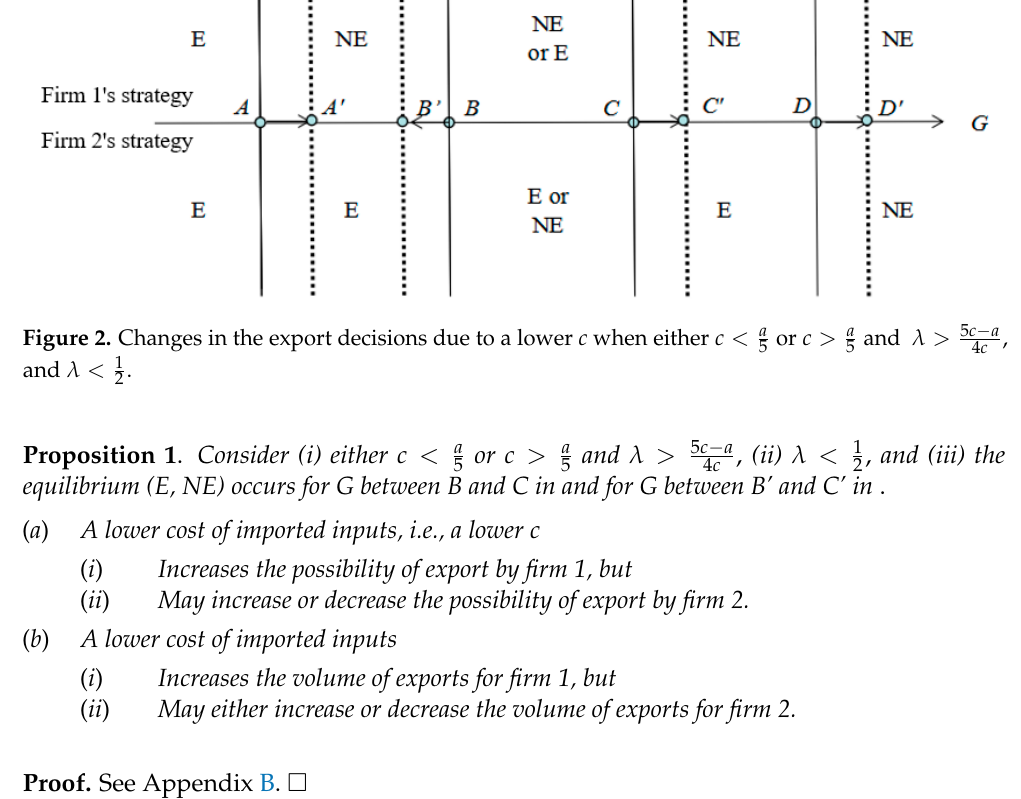
or c > a and λ > 5 c − a , or (cid:1855) > (cid:3028) and (cid:2019) > (cid:2873)(cid:3030)(cid:2879)(cid:3028) , 5 5 4 c (cid:2873) (cid:2873) (cid:2872)(cid:3030)